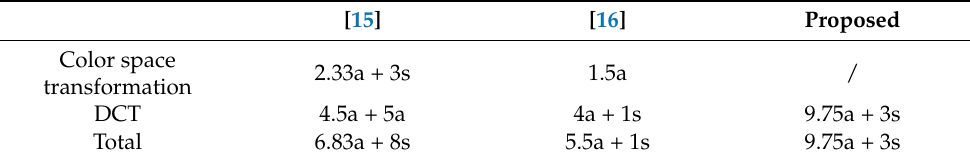
Table 3. Computational complexity comparison (“a” for additions and “s” for shifts).